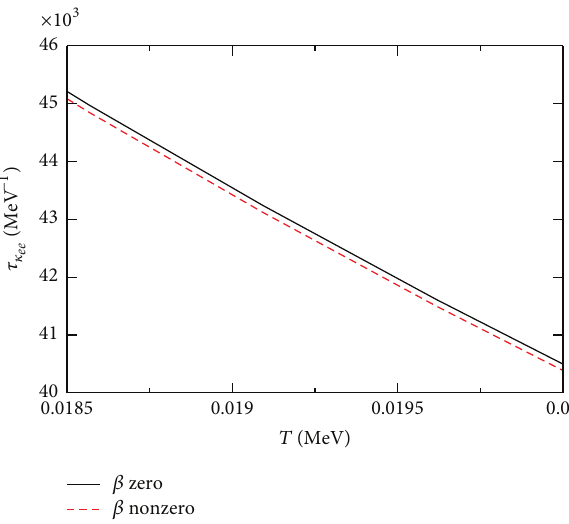
Figure 11: The reduction of 𝜏 𝜅